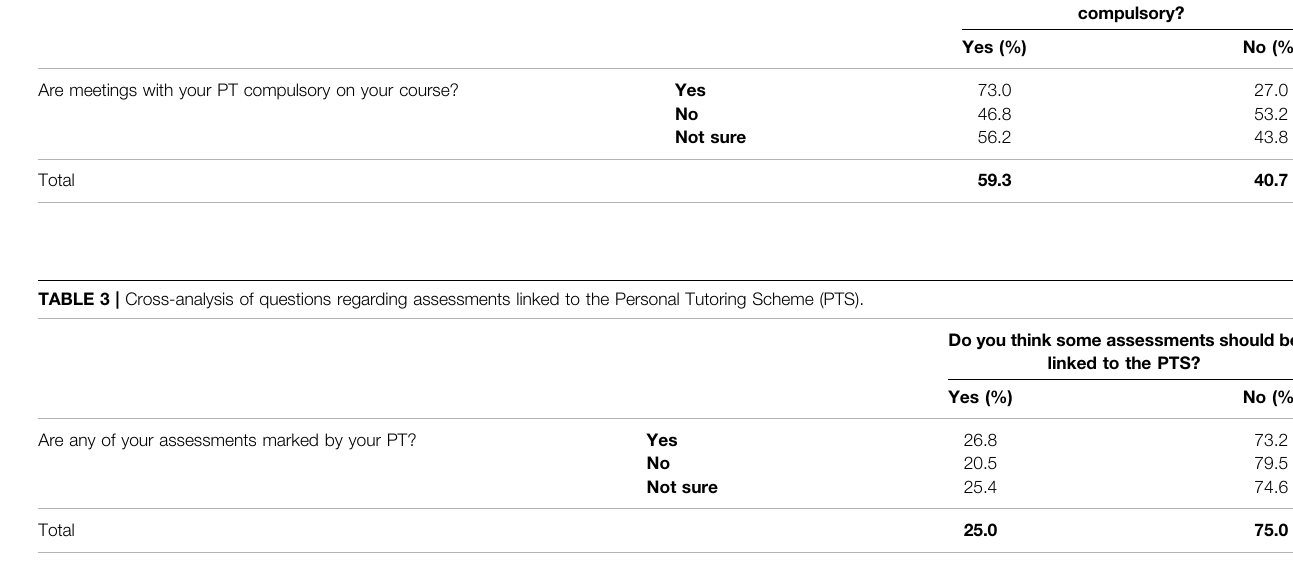
TABLE 2 | Cross-analysis to explore students ’ preferences regarding whether PTS meetings should be compulsory.